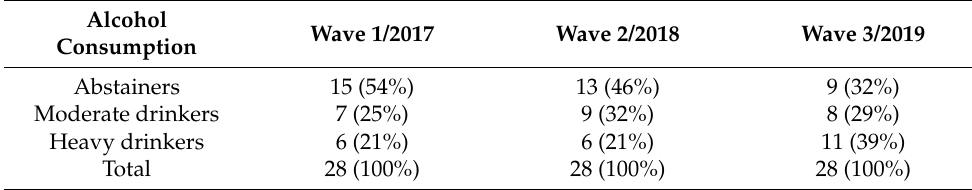
Table 1. Drinking categories in the study (N =